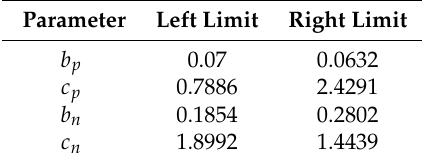
Table 3. Left and Right Limits for bilateral gamma parameters as functions of moneyness. Parameter Left Limit Right Limit b p